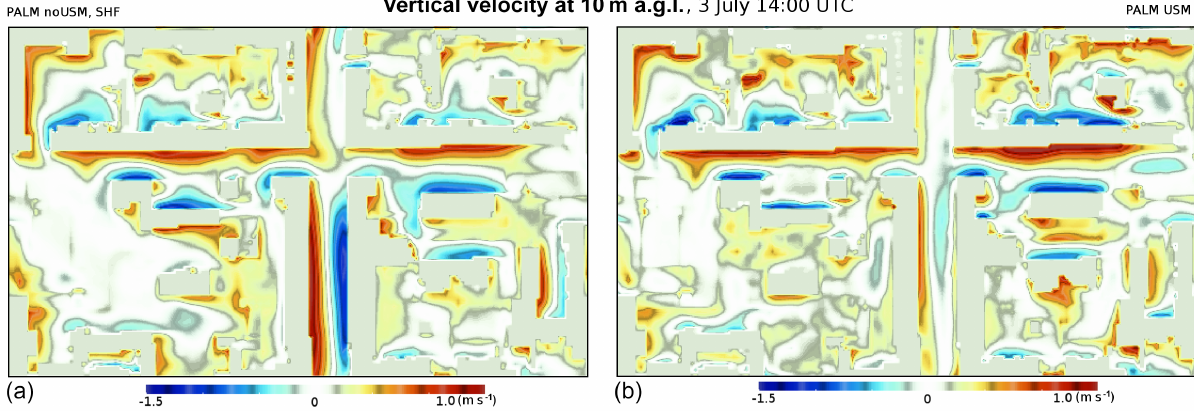
Figure 16. Horizontal view of modelled vertical velocity (1h average) at 10ma . g . l . on 3 July, 14:00UTC. (a) presents a stationary simulation without USM with constant surface heat fluxes and (b) the reference simulation with USM